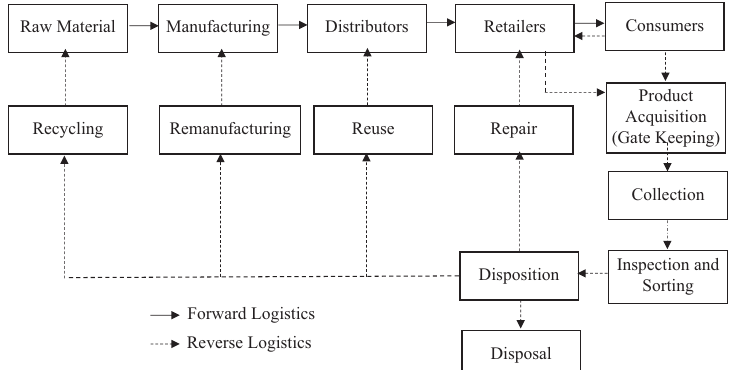
Figure 1. Fundamental flow of RL and forward logistics